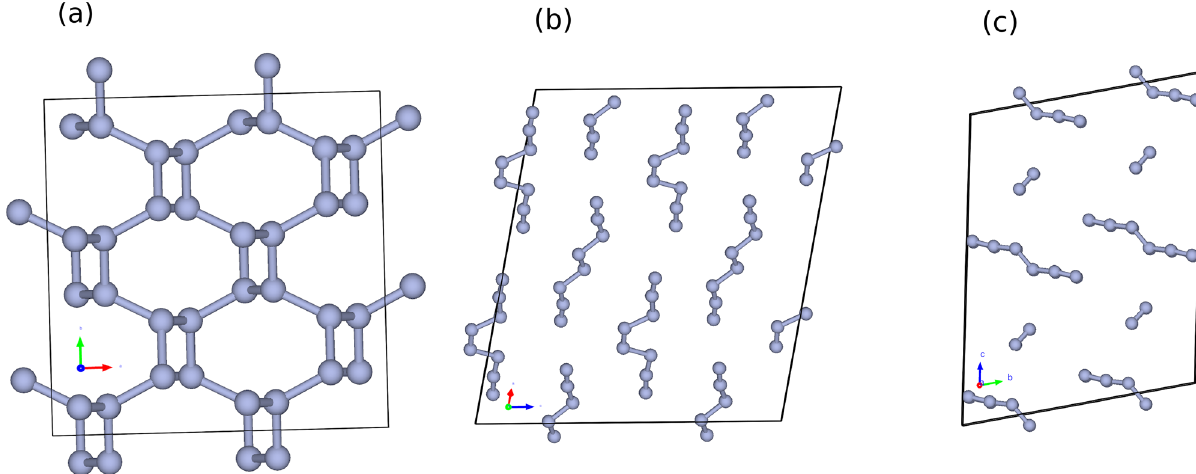
Figure 1. The crystal arrangement of three polymeric nitrogen compounds: ( a ) cg-PN predicted in 1992 and synthesized in 2004 by compressing N 2 above 110 GPa and 2000 K. ( b ) The 2N 8 molecular crystal predicted in 2013 and synthesized in 2018 by compressing hydrazinium azide above 40 GPa. ( c ) The molecular N 6 –N 2 system investigated computationally in this work at zero